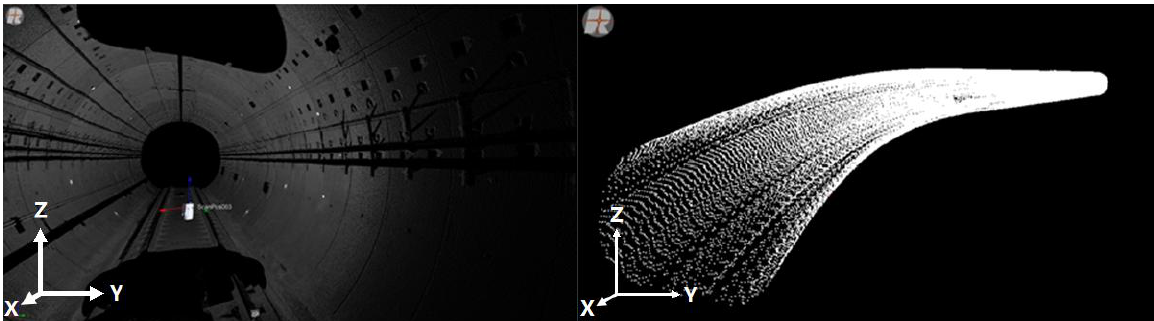
Figure 8. The experimental dataset.